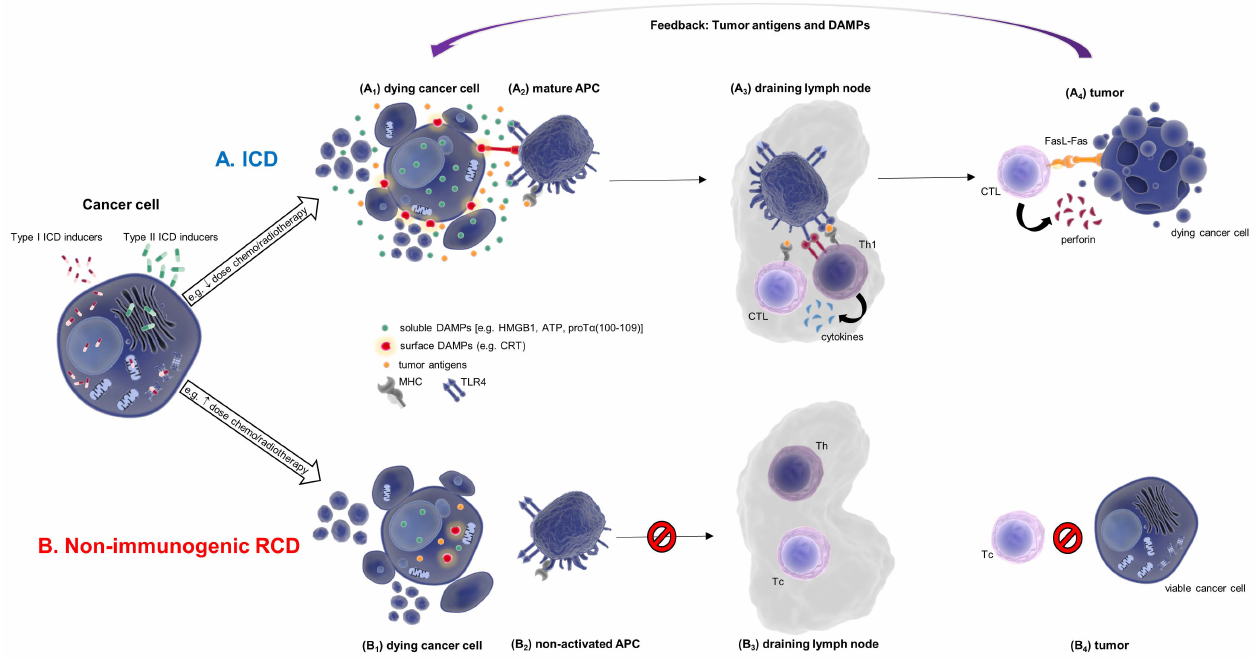
Figure 1. Differences in adaptive immune responses following induction of ICD and non- immunogenic RCD. ( A ) In ICD, type I ICD inducers trigger indirect ER stress; type II ICD inducers trigger direct ER stress. The dying cancer cell releases tumor antigens and DAMPs (e.g., HMGB1, ATP, proT α (100–109)), while “eat-me” signals (e.g., CRT) are exposed on the cell surface (A1). Maturation of APCs increases cancer antigen uptake and MHC class II and I are overexpressed (A2). Mature APCs traffic to the draining lymph node, produce Th1-polarizing cytokines and chemokines, and activate helper T (Th1) and cytotoxic T cells (CTLs) (A3). CTLs traffic to the tumor and, via the secretory (perforin) or the non-secretory (Fas-FaL) pathways, kill cancer cells (A4). The de novo released tumor antigens and DAMPs act as feedback signals and refuel the ICD cycle (arrow). ( B ) In non-immunogenic RCD, the dying cancer cell does not release tumor antigens and DAMPs (B1), APCs are not activated (B2), helper and cytotoxic T cell responses are not stimulated (B3), and cancer cells remain viable